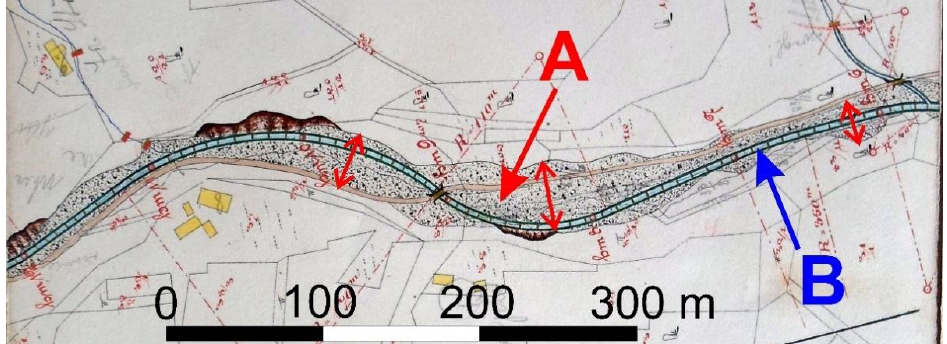
Figure 6. The first construction plan of the torrent control works in the Vysutý from the beginning of the 20th century as an illustrative example of the morphological alteration of local mountain headwater streams. Original active channel with extensive gravel and cobble out-of-channel deposits (( A ) the red arrows show the extend of the deposits) was replaced by a narrow (~5 m) channel stabilized by a dense sequence of grade control structures ( B ).